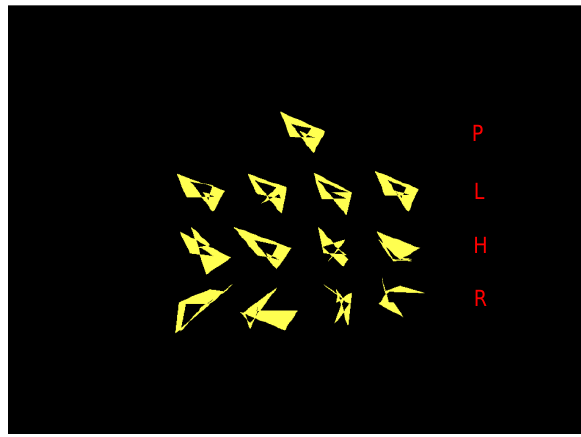
Figure 2. A dot-distortion category, with the originating prototype (P), low-level distortions (L), high-level distortions (H), and random-unrelated shapes (R) in the top to bottom rows, respectively. Adapted from [18]. Copyright 2008 by the American Psychological Association. Reprinted with permission.